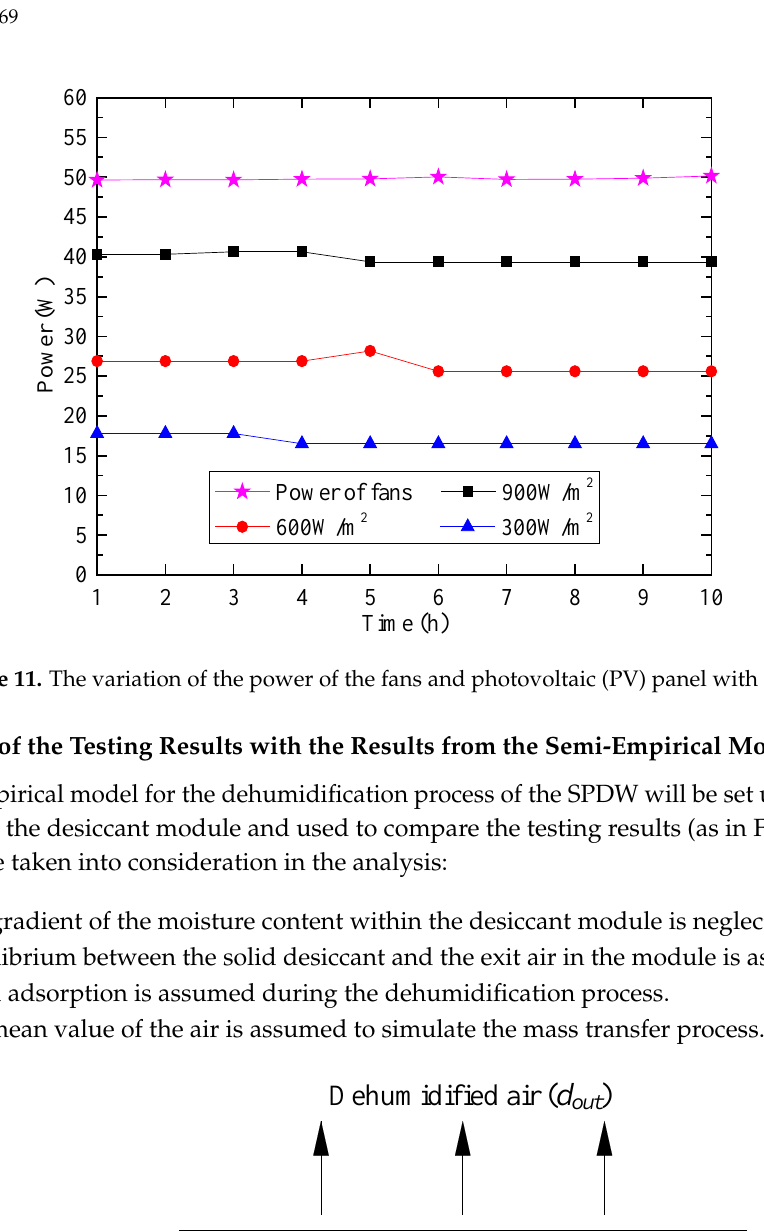
Figure 12. The mass transfer process for the proposed solid desiccant module.